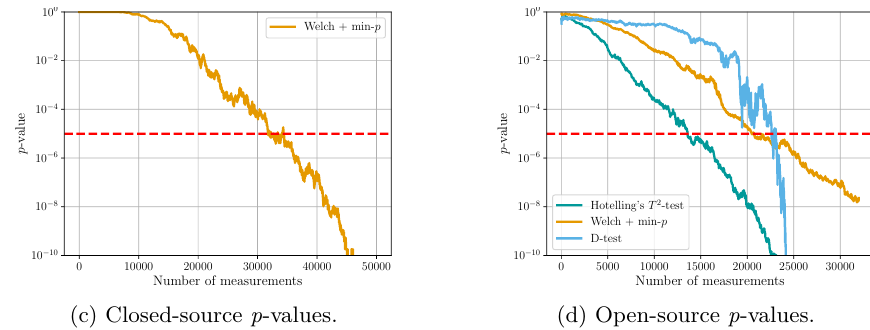
Figure 11: Leakage detection results: masked software AES